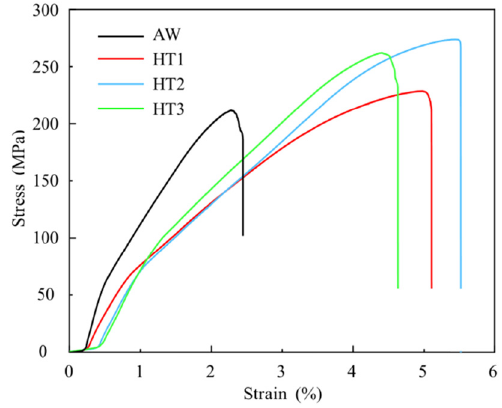
Figure 7: Tensile stress – strain curves of joints under di ff erent conditions.